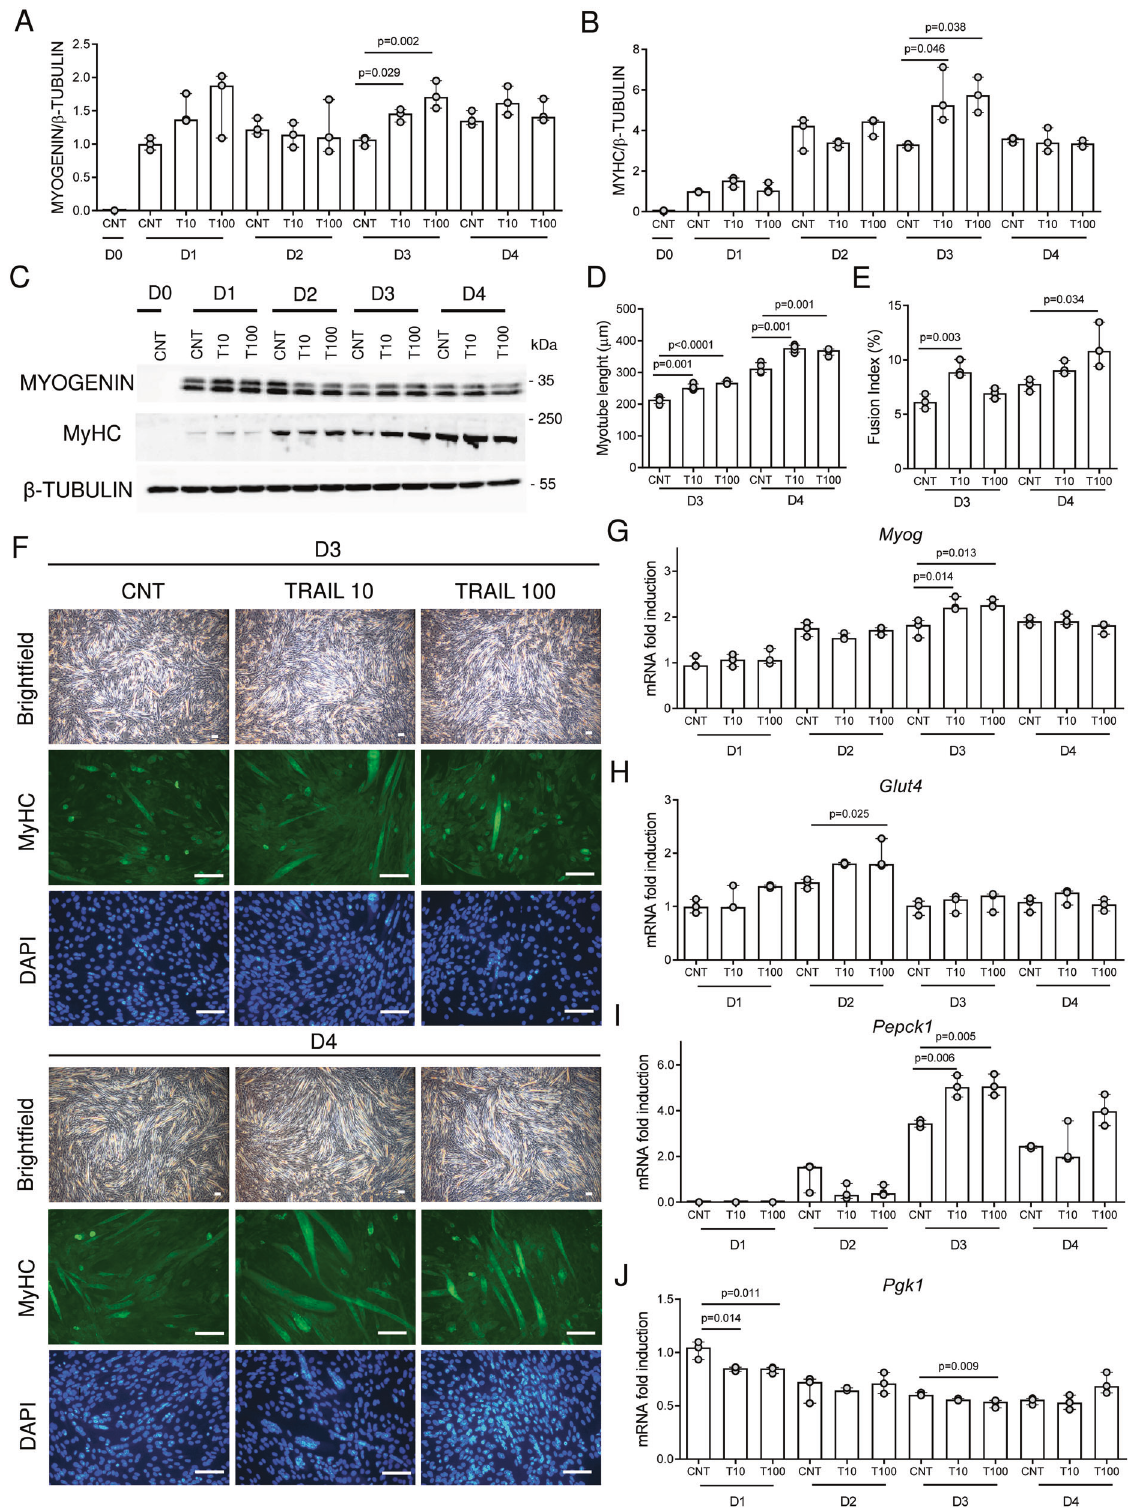
Fig. 2 TRAIL promotes myogenic differentiation. Experiments were conducted in C2C12 cells during their differentiation. TRAIL treatment was renewed every 24 h between D0 and D4 (D is for day of differentiation). A – B Densitometric analysis and C representative blots of myogenin and MyHC protein expression. D Myotube length. E Fusion index. F Representative images of C2C12 cell morphology. Bright fi eld (upper panels), MyHC immuno fl uorescence (middle panels), DAPI staining (lower panels). Scale bar represents 100 µm. G – J Gene expression of Myog , Glut4 , Pepck1 , and Pgk1 . Gene expression is reported as mRNA fold induction normalized to the mRNA level of CNT cells on D1. Results were obtained by 3 – 4 independent experiments and are presented as median with interquartile range. Signi fi cance was assessed with ANOVA and